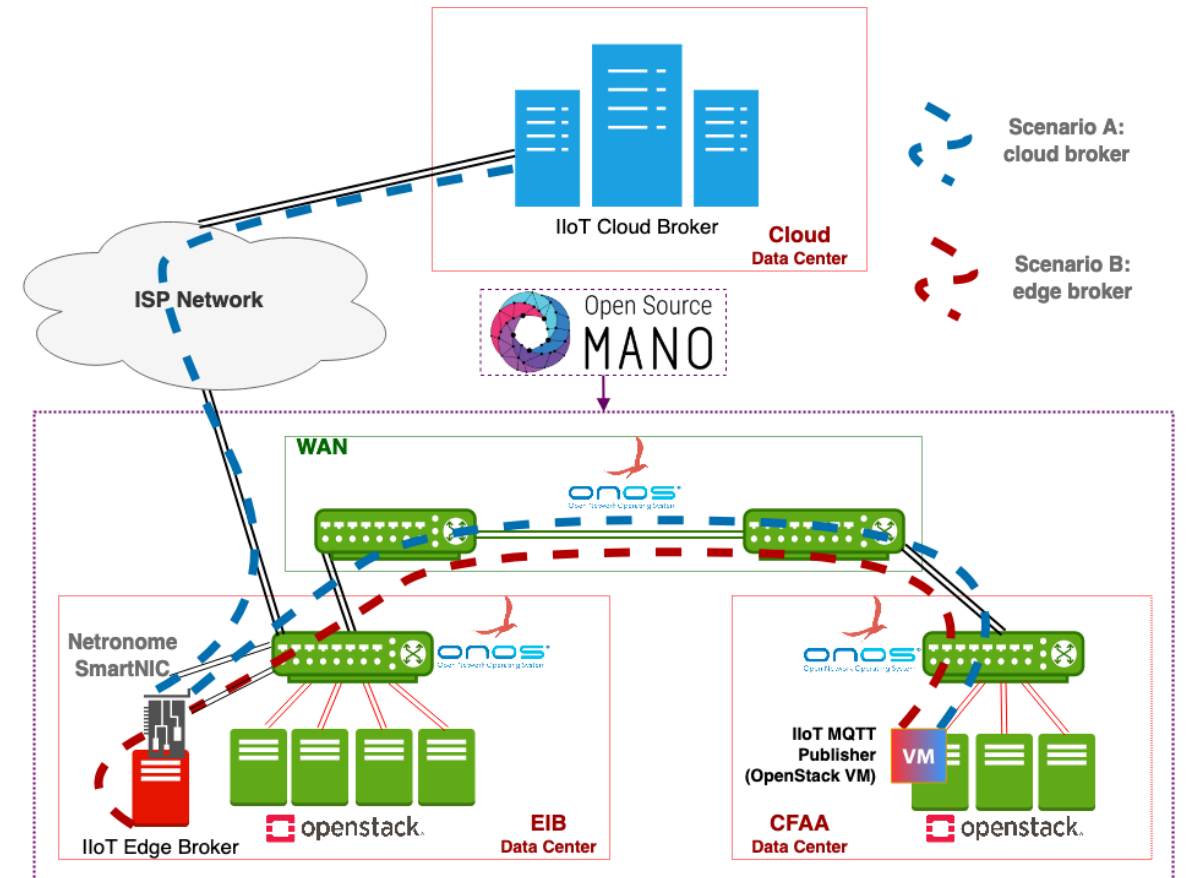
Figure 8. Testbed network of the industrial architecture based on